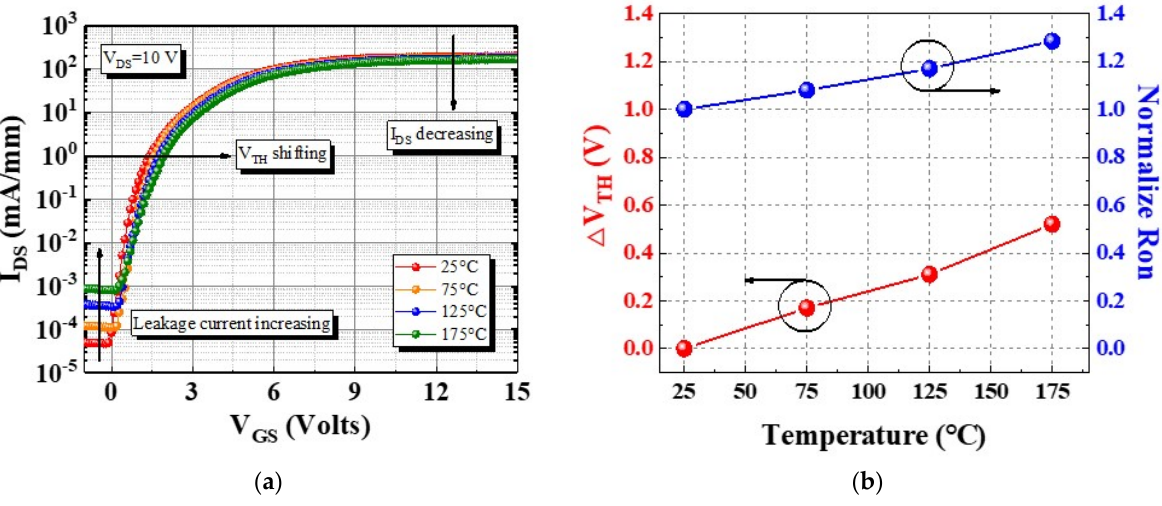
Figure 7. ( a ) I DS –V GS characteristics of the device at 25 °C to 175 °C, and ( b ) variation in V TH and Ron.